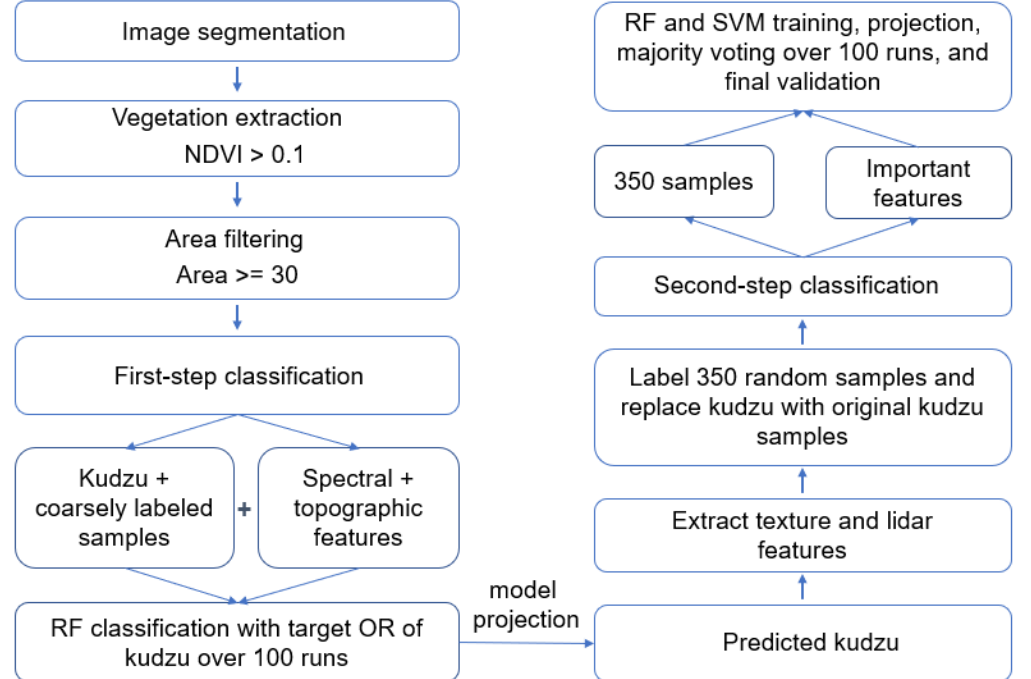
Figure 1. Workflow of the proposed method on classifying kudzu with decreased sampling effort and computational cost.